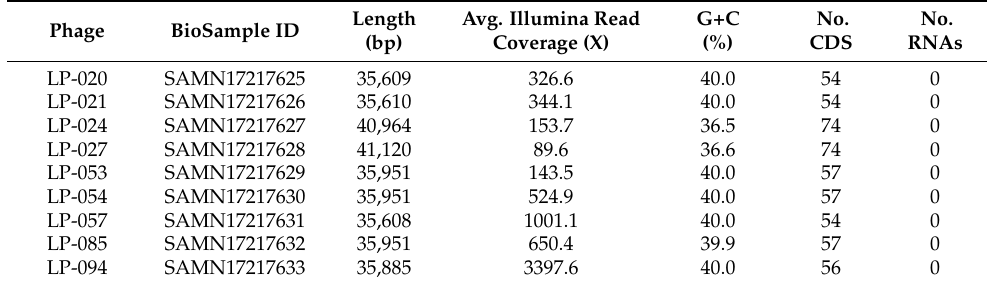
Table 4. Assembly statistics for Listeria